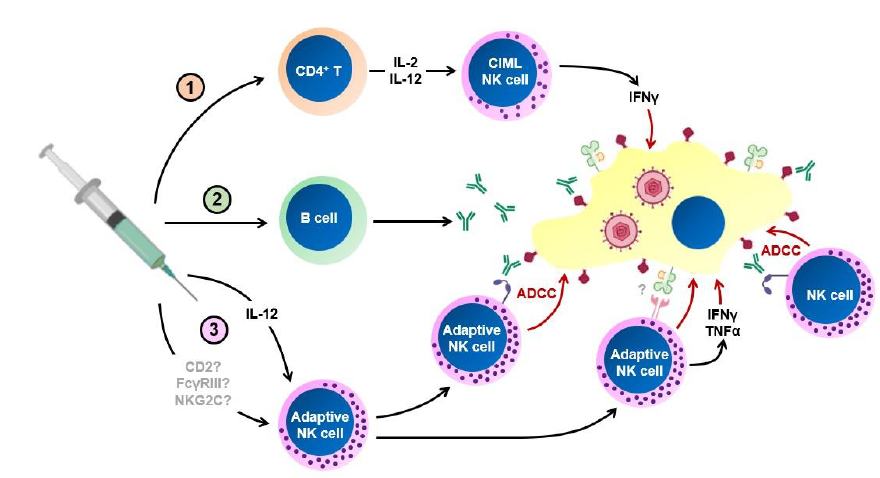
Figure 1. Mechanisms by which NK cells could be harnessed in human cytomegalovirus (HCMV) vaccination. 1,2. Vaccination traditionally targets aspects of the adaptive immune response, for which NK cells can act as effectors. 1. Antigen-specific CD4 + T cells produce IL-2 and IL-12, which can lead to the production of cytokine-induced memory-like NK cells (CIML). These produce increased levels of IFNγ, which cou ld help control HCMV. 2. B cell produce antibodies, which can coat virally-infected target cells. NK cells kill the antibody-coated target cell by ADCC, controlling the virus. 3. Natural HCMV infection and some vaccine formulations may be able to induce adaptive NK cells via the induction of IL-12. As-yet-undefined receptor-ligand interactions are also likely to be important for the induction of these cells, with CD2, FcγRIII (CD16) and NKG2C key candidate molecules to be involved in this process. Adaptive NK cells display increased ability to mediate ADCC, and to release cytotoxic granules in response to HCMV-infected cells, although the receptor-ligand interactions that are required for this are not yet fully defined. They may further be able to control the virus by their increased ability to produce IFNγ and TNFα.